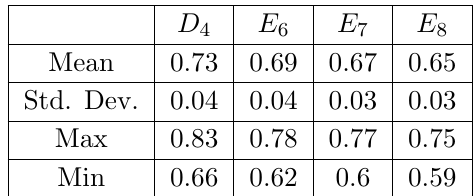
Table 4. Table of means and standard deviations for the ratio a IR =c IR across the entire nilpotent network de(cid:12)ned by (cid:13)ipper (cid:12)eld deformations of probe D3-brane theories. We also display the maximum and minimum values.